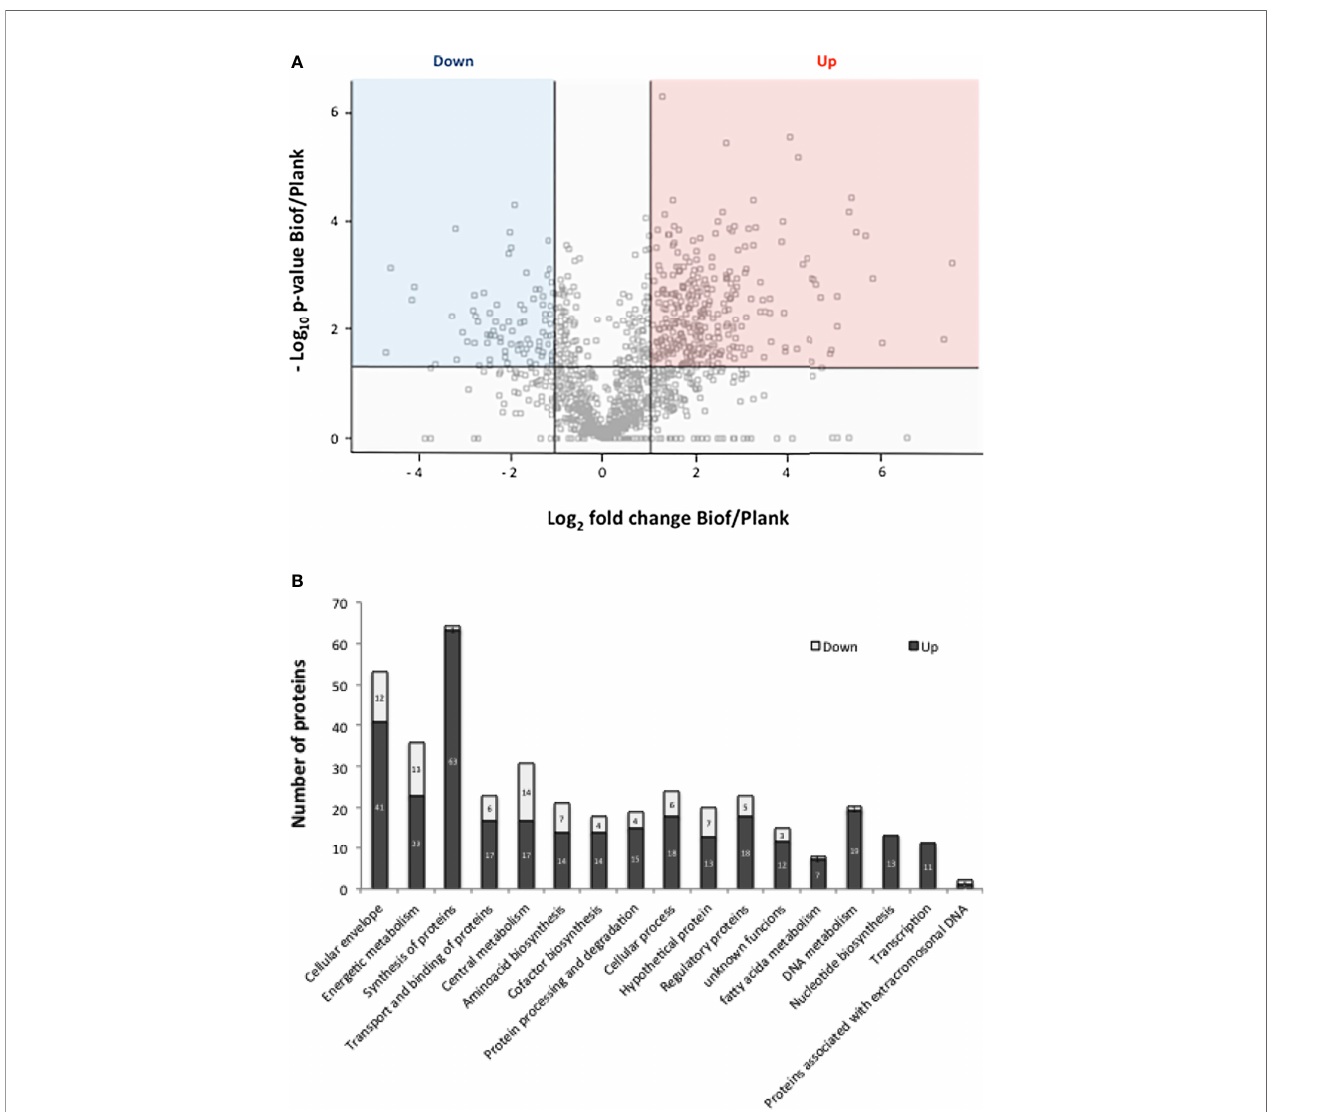
FIGURE 3 | (A) Volcano plot of protein samples from the clinical isolate B . pertussis BpAR106 grown in bio fi lm (Biof) or planktonic (Plank) condition. -Log 10 of the p -value associated with the magnitude of the fold-change of a given protein between the bio fi lm and planktonic growth conditions is plotted on the ordinate as a function of the log 2 of that fold change on the abscissa. M = log 2 (fold-change). The overexpressed proteins are indicated in red (M ≥ 1), and the underexpressed proteins in blue (M ≤ − 1) based on p <0.05. The proteins located on the 0 line correspond to the ON/OFF proteins since those proteins did not have an associated p -value. (B) Representation of the different clusters of orthologous groups (COGs) containing the proteins differentially expressed under bio fi lm culture condition of B . pertussis BpAR106. In the fi gure, the bar length represents the number of overexpressed (black) or underexpressed (gray) proteins within each COG among the total differentially expressed